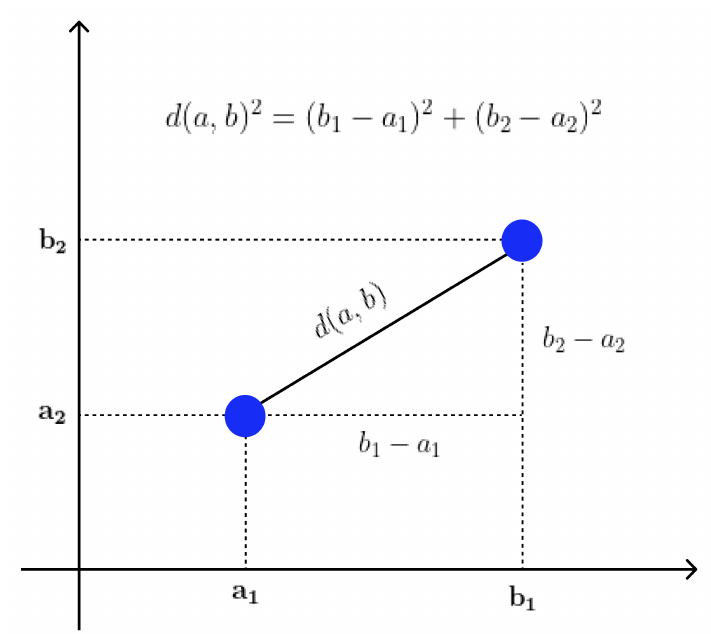
Figure 5. Euclidean distance between two points: a and b .